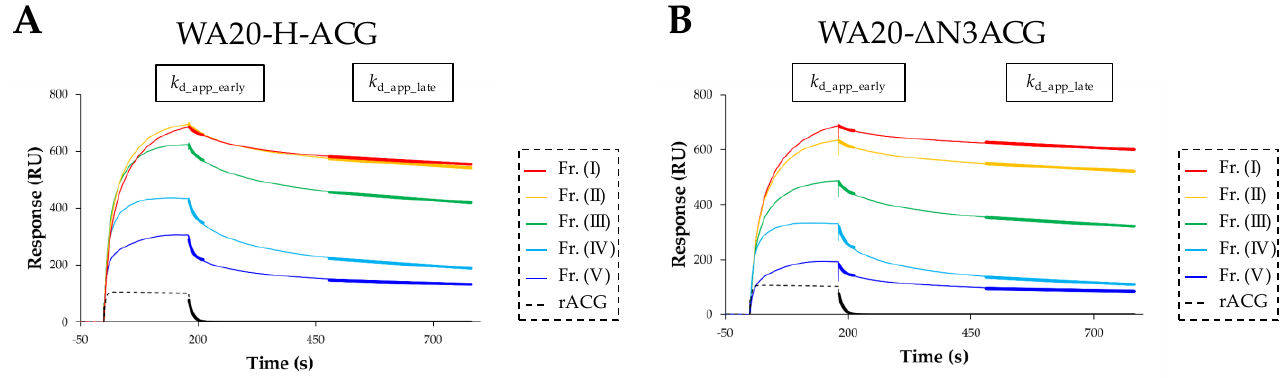
Figure 7. SPR analysis. Sensorgrams of the fractionated samples (Fr.) of the lectin nano-block oligo- mers of ( A ) WA20-H-ACG and ( B ) WA20- ΔN3ACG at 1 µM bound to the 3 ′ -sialyllactose ligand. The sensorgram of rACG at 1 µM is also shown for comparison. Sensorgrams of all samples at all concentrations are shown in Figures S13 and S14. Bold lines show the fitting curves used for calcu- lating the apparent dissociation rate constants k d_app_early in the early phase (181 – 211 s) and k d_app_late in the late phase (480 – 780 s) of the lectin nano-block oligomers. The apparent dissociation rate con- stant k d_app of rACG was calculated using the data in the entire dissociation time (181 – 780 s). Table 4. Summary of the SPR analysis results.